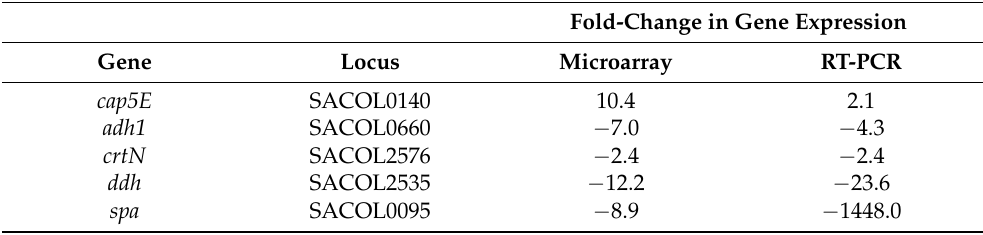
Table 2. qRT-PCR validation of select SH10001st-2 genes identified as altered via microarray. Fold-Change in Gene Expression